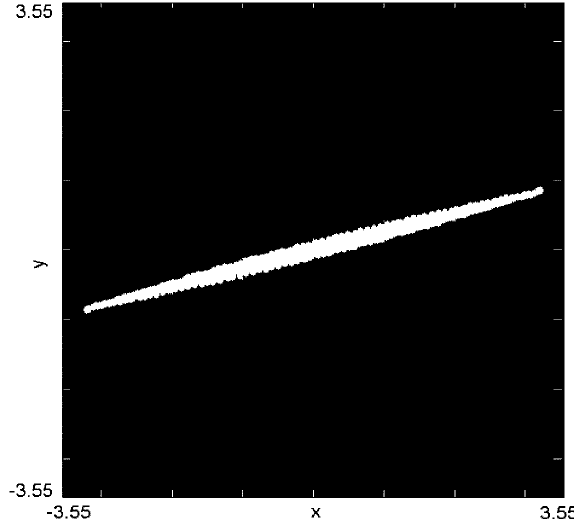
FIG. 5. Beam distribution generated by OMNITRAK at the vertical focal point. Initial beam radius: 0.8 cm. R (cid:1) 1 : 818 . Dimensions in mm. Fiducial intervals in x 2 : 200 , R y and y : 1.0